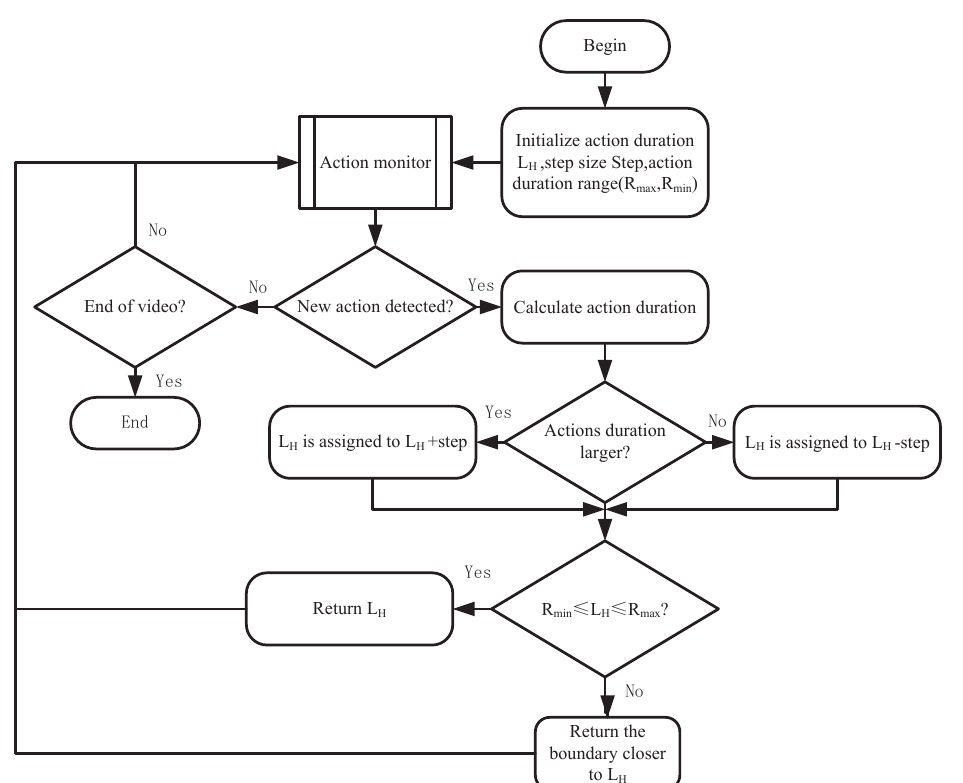
Figure 7. The processing flow of action duration